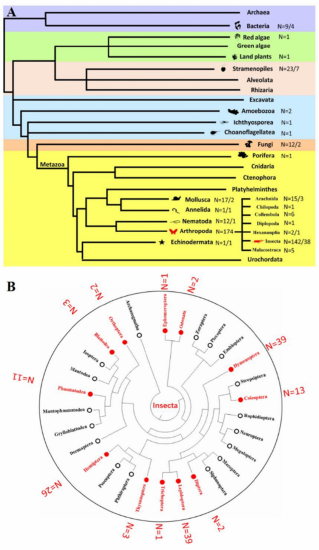
Figure 3. Taxonomic distribution of Sailor . ( A ) Taxonomic distribution of Sailor elements in the different kingdoms. The numbers next to the animal silhouettes represent the number of Sailor elements detected in the species of each lineage. The number after the slash represents the intact Sailor. ( B ) Taxonomic distribution of Sailor elements in Insecta. The taxonomic tree represents the distribution of the species identified in Insecta in their respective orders. Insecta orders are labelled with a square node and the number of Insecta species is shown outside the circle. The phylogenetic relationships were taken from the TimeTree database (http://timetree.org/, accessed on 5 June 2021)